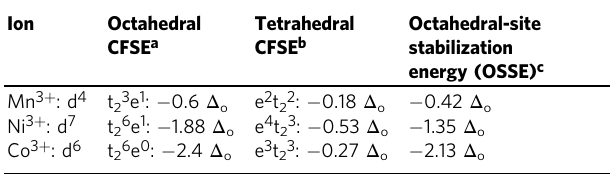
Table 2 Comparison of the crystal fi eld stabilization energies (CFSE) of the transition-metal ions M 3 + in NMC